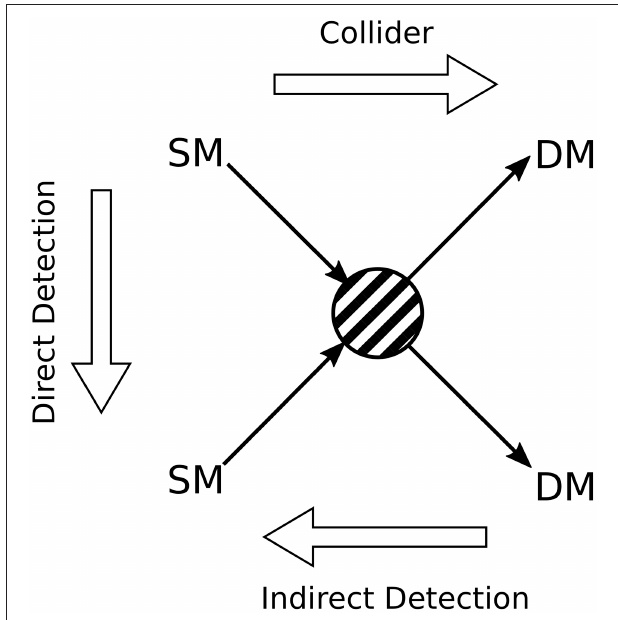
FIGURE 1 | Schematic showing the possible dark matter detection